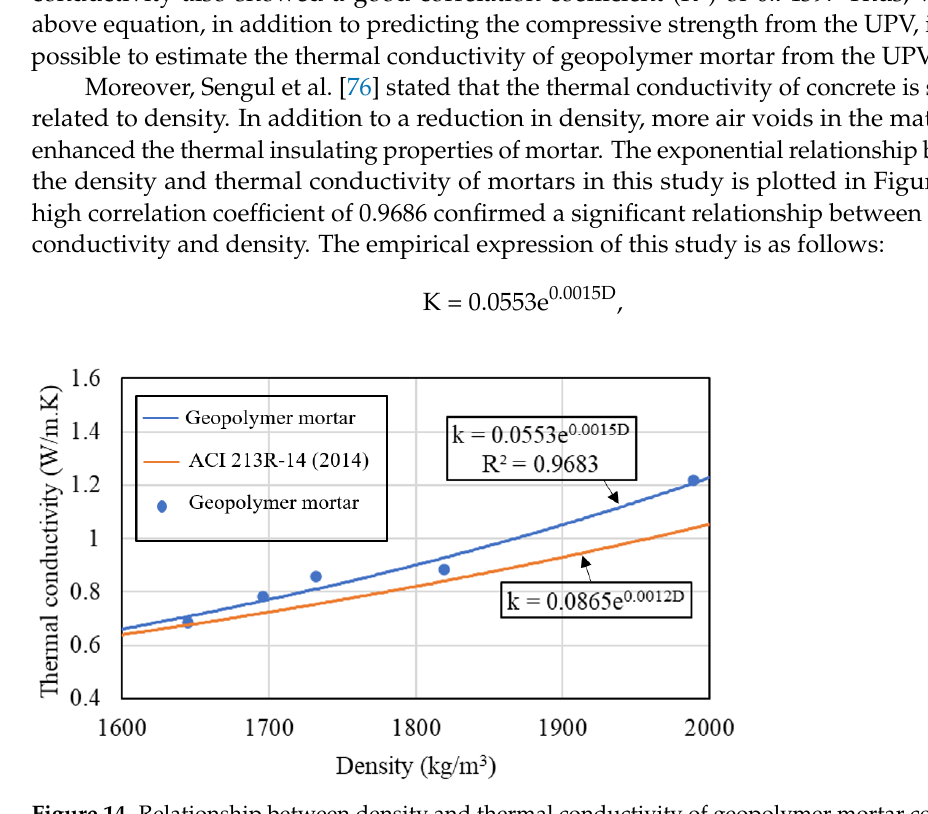
Figure 13. Relationship between UPV and thermal conductivity of geopolymer mortar containing BLWA.